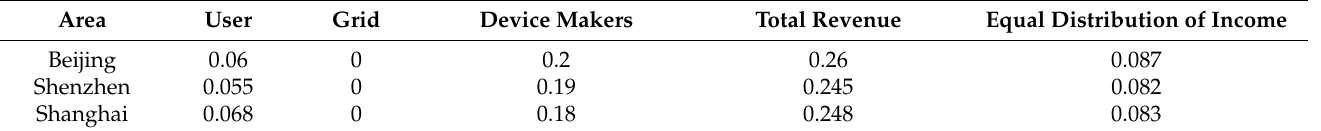
Table 9. Income of various stakeholders in different regions in the office building scenario (unit: Yuan/W).